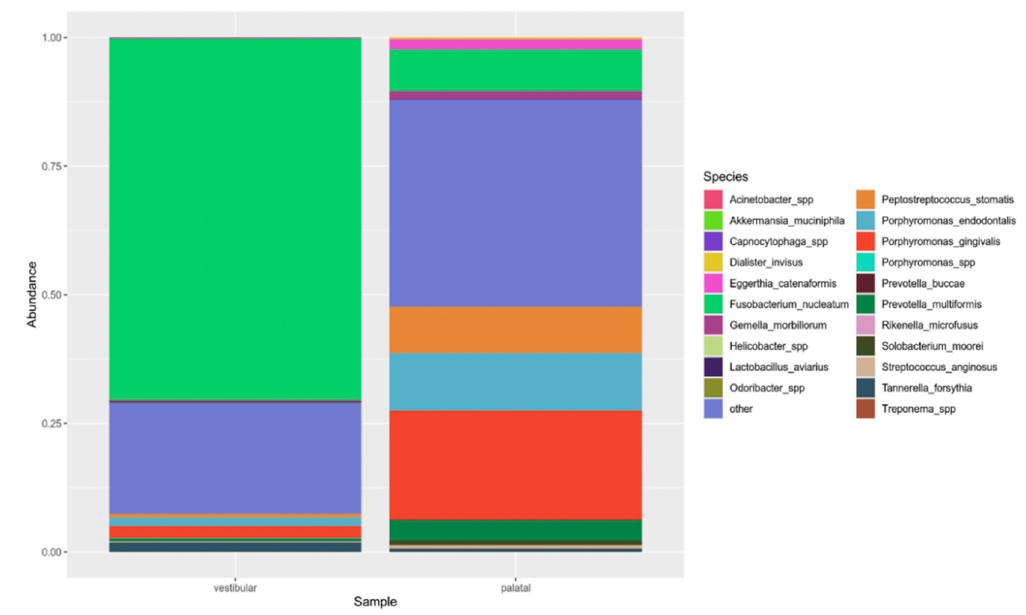
Figure 4. Relative abundance of taxa in the vestibular and palatal samples. The top 15 species and genera are shown.